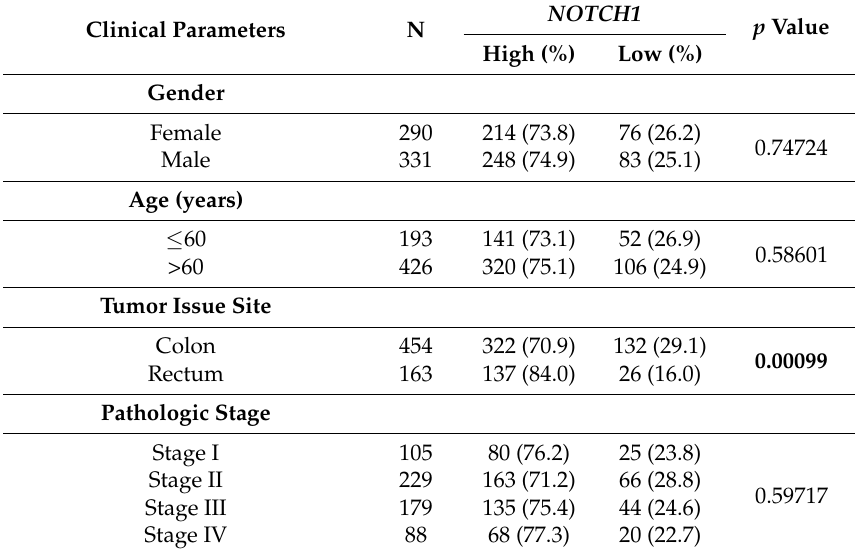
Table 2. Correlation between NOTCH1 expression and clinical parameters in patients with